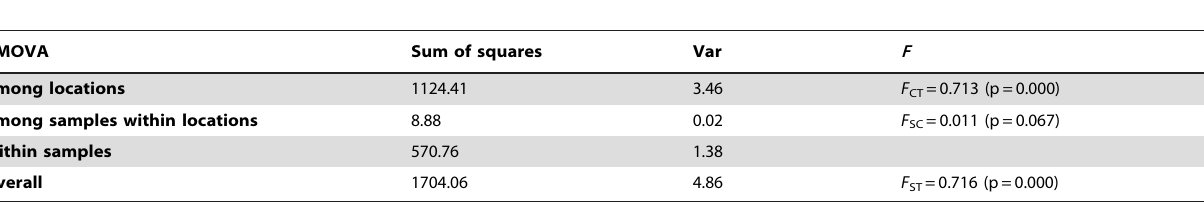
Table 5. Results from AMOVA analysis partitioning genetic differentiation among locations (4 locations: Zadlascica, Lipovscek, Sevnica and Studenc) and among samples within locations (pre- and post-flood samples).